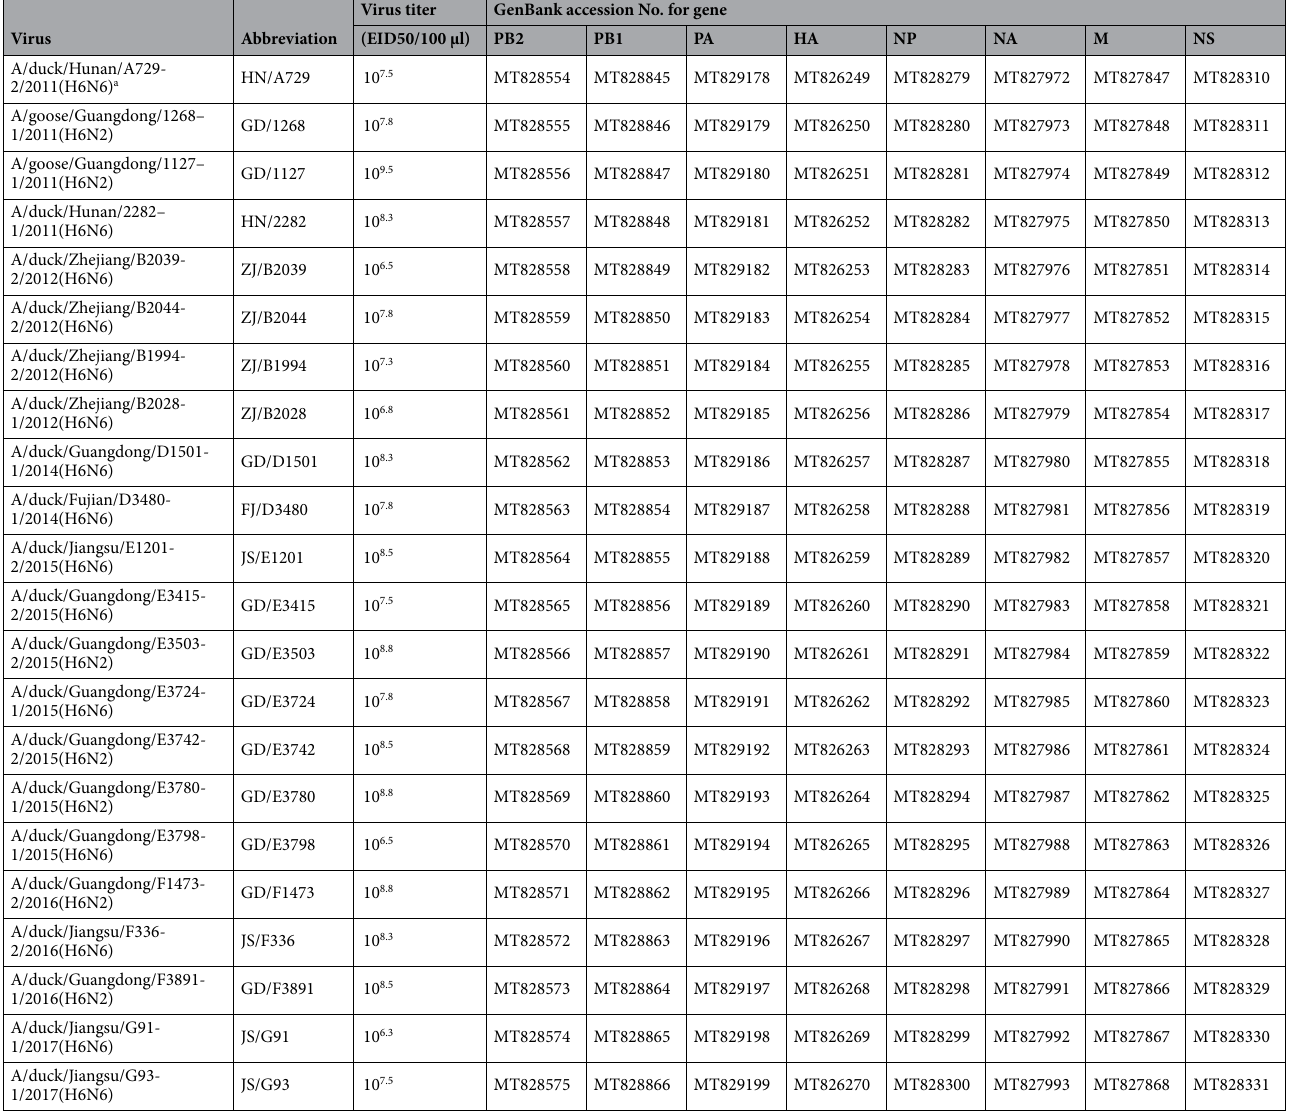
Table 1. Abbreviations used and GenBank accession numbers for H6 Avian Influenza virus isolates. a Viruses whose PB2, PB, PA, HA, NP, NA, M and NS genes were sequenced in the present